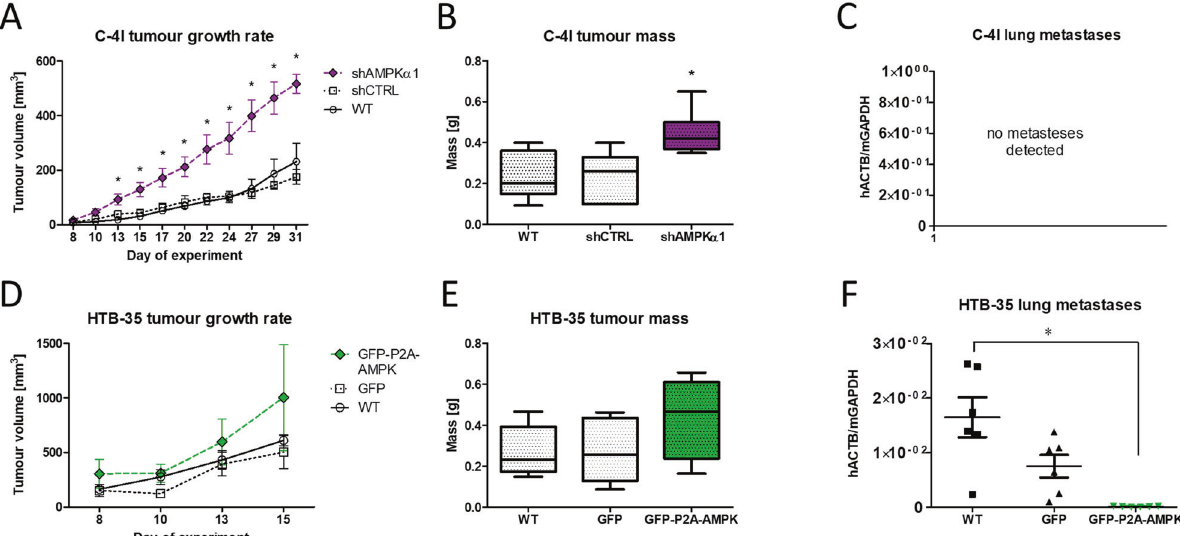
Fig. 6 Tumor formation by subcutaneous injection of CC cells in the NOD-SCID mice. The volumetric growth rate of tumors calculated from percutaneous tumor measurements for C-4I ( A ) and HTB-35 ( D ) cells. Box plots show the mass of isolated tumors for each of three lines C-4I ( B ) and HTB-35 ( E ). Assessment of human β -actin transcript levels in lung samples isolated from mice with C-4I and HTB-35 injected cells ( C , F ). The ability to form metastases is directly proportional to the amount of human β -actin transcript in relation to the mouse GAPDH gene. All graphs represent data from two rounds of independent experiments ± SEM (2 × n = 3 for each cell line). Asterisks indicate statistically signi fi cant differences ( p <